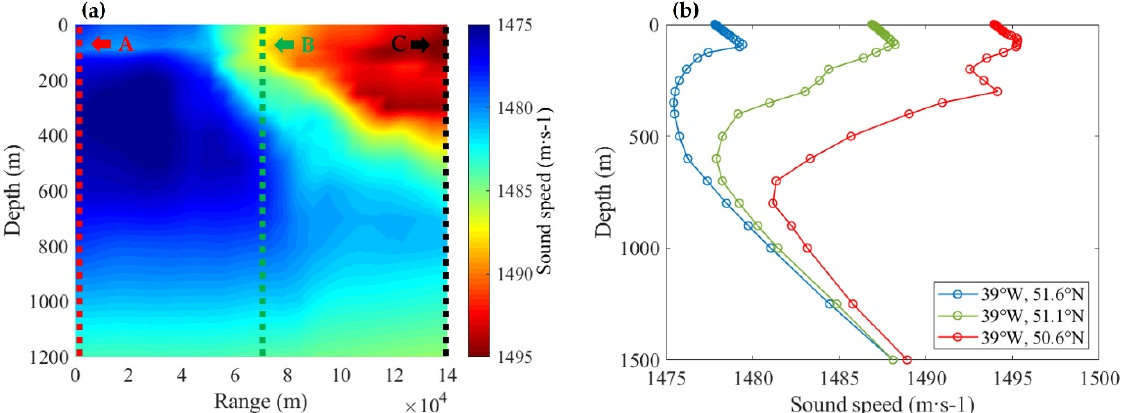
Figure 3. ( a ) The sound speed section at 39 ◦ W (0–1000 m); ( b ) the sound speed profiles of point A (39 ◦ W, 51.6 ◦ N), B (39 ◦ W, 51.1 ◦ N), and C (39 ◦ W, 50.6 ◦ N) (0–1500 m). Point A is located on the leftmost side, point B is located in the middle, and point C is located on the rightmost